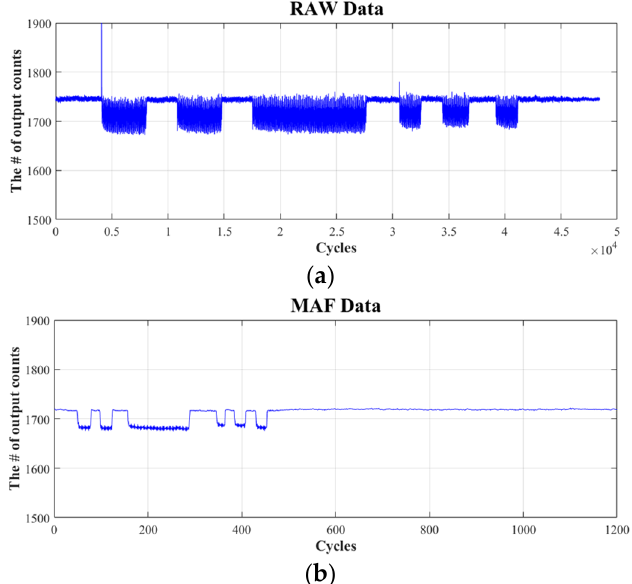
Figure 8. ( a ) Raw data; ( b ) MAF data when a finger touches the electrode with the same pattern.